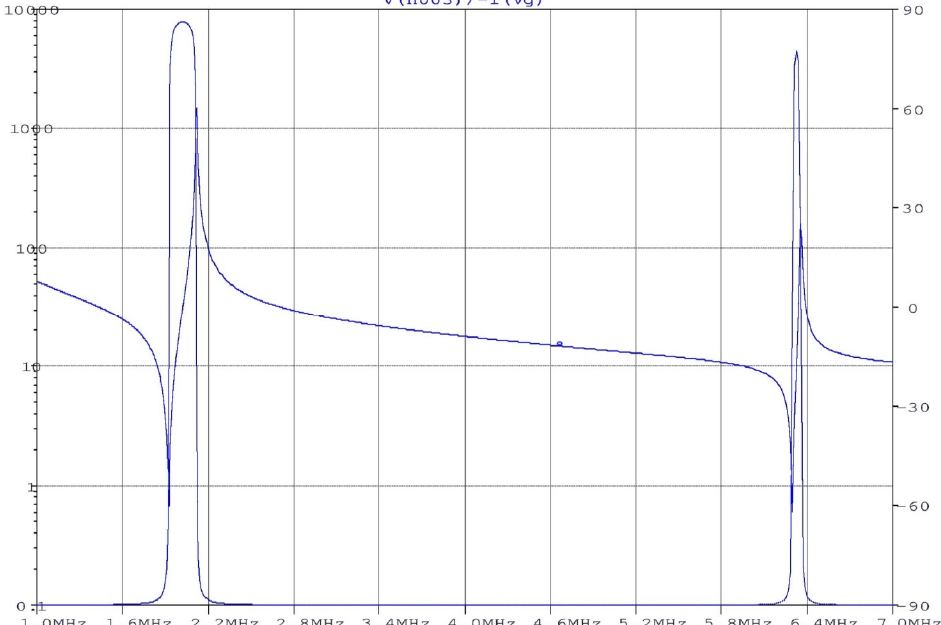
Figure 12. Plot of the modelled impedance of a device using a single piezoelectric element.